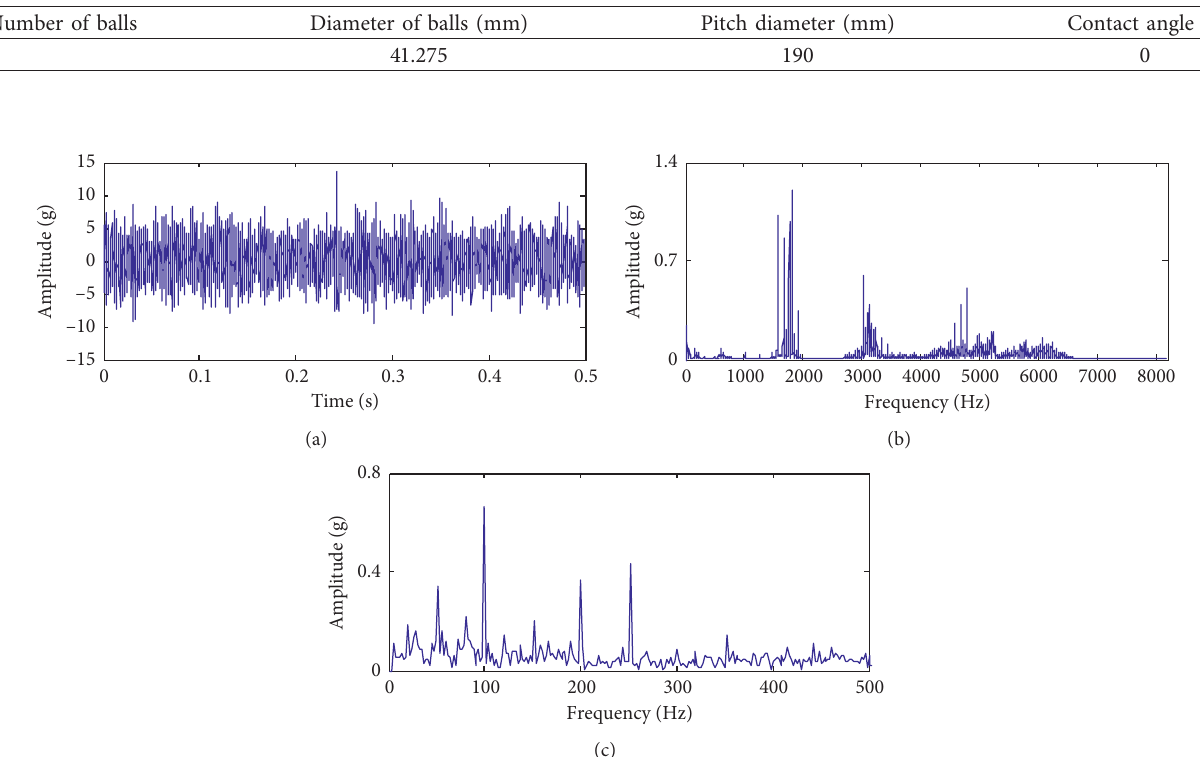
Table 2: Structure parameters of SKF6324 bearing.